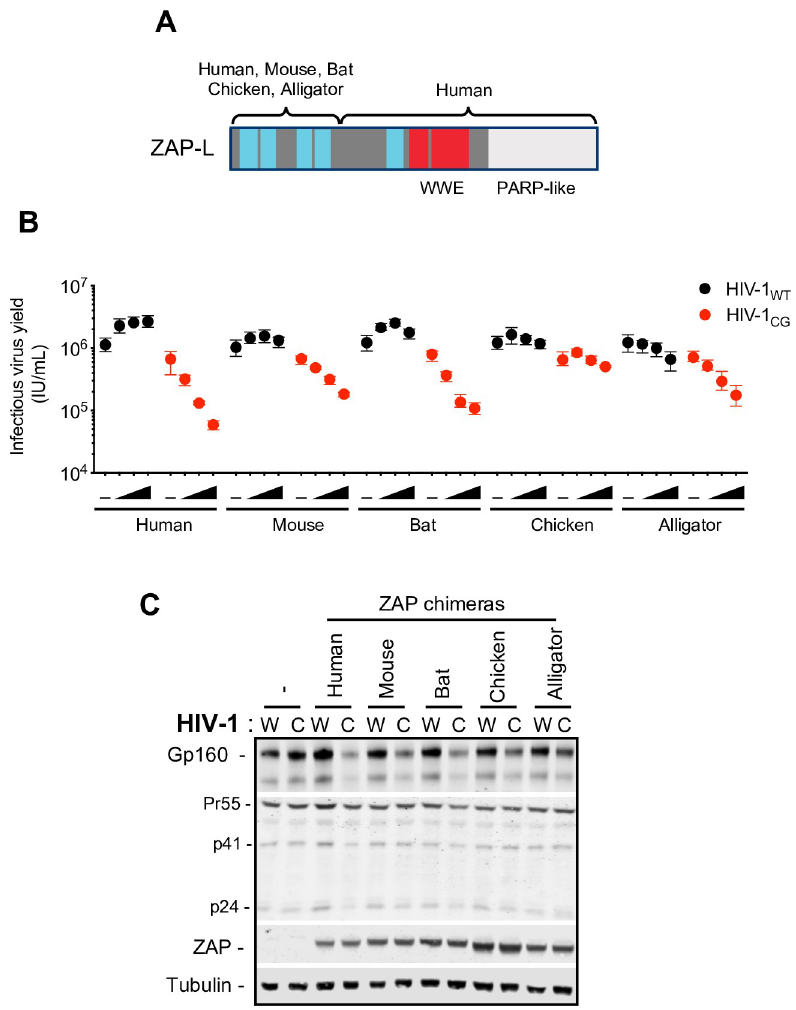
Fig 4. ZAP protein antiviral activity in human cells. (A) Schematic representation of ZAP chimeras in which the RNA binding domain of mouse, bat, chicken and alligator ZAP was fused to the WWE and PARP-like domain of human ZAP. (B-C) HEK293T ZAP -/- cells were transfected with HIV-1 WT (W) or HIV-1 CG (C) proviral plasmids and increasing amounts (0ng, 75ng, 145ng, or 290ng) of a plasmid encoding each ZAP chimera. Supernatant was harvested after 48h and the infectious virus yield was determined using MT4-R5-GFP target cells (B). Whole cell lysates corresponding to the highest amount of ZAP plasmids transfected were analysed by western blotting probing with antibodies against HIV-1 proteins and ZAP (C). -, Indicates co-transfection with an empty vector in place of a ZAP expression plasmid.